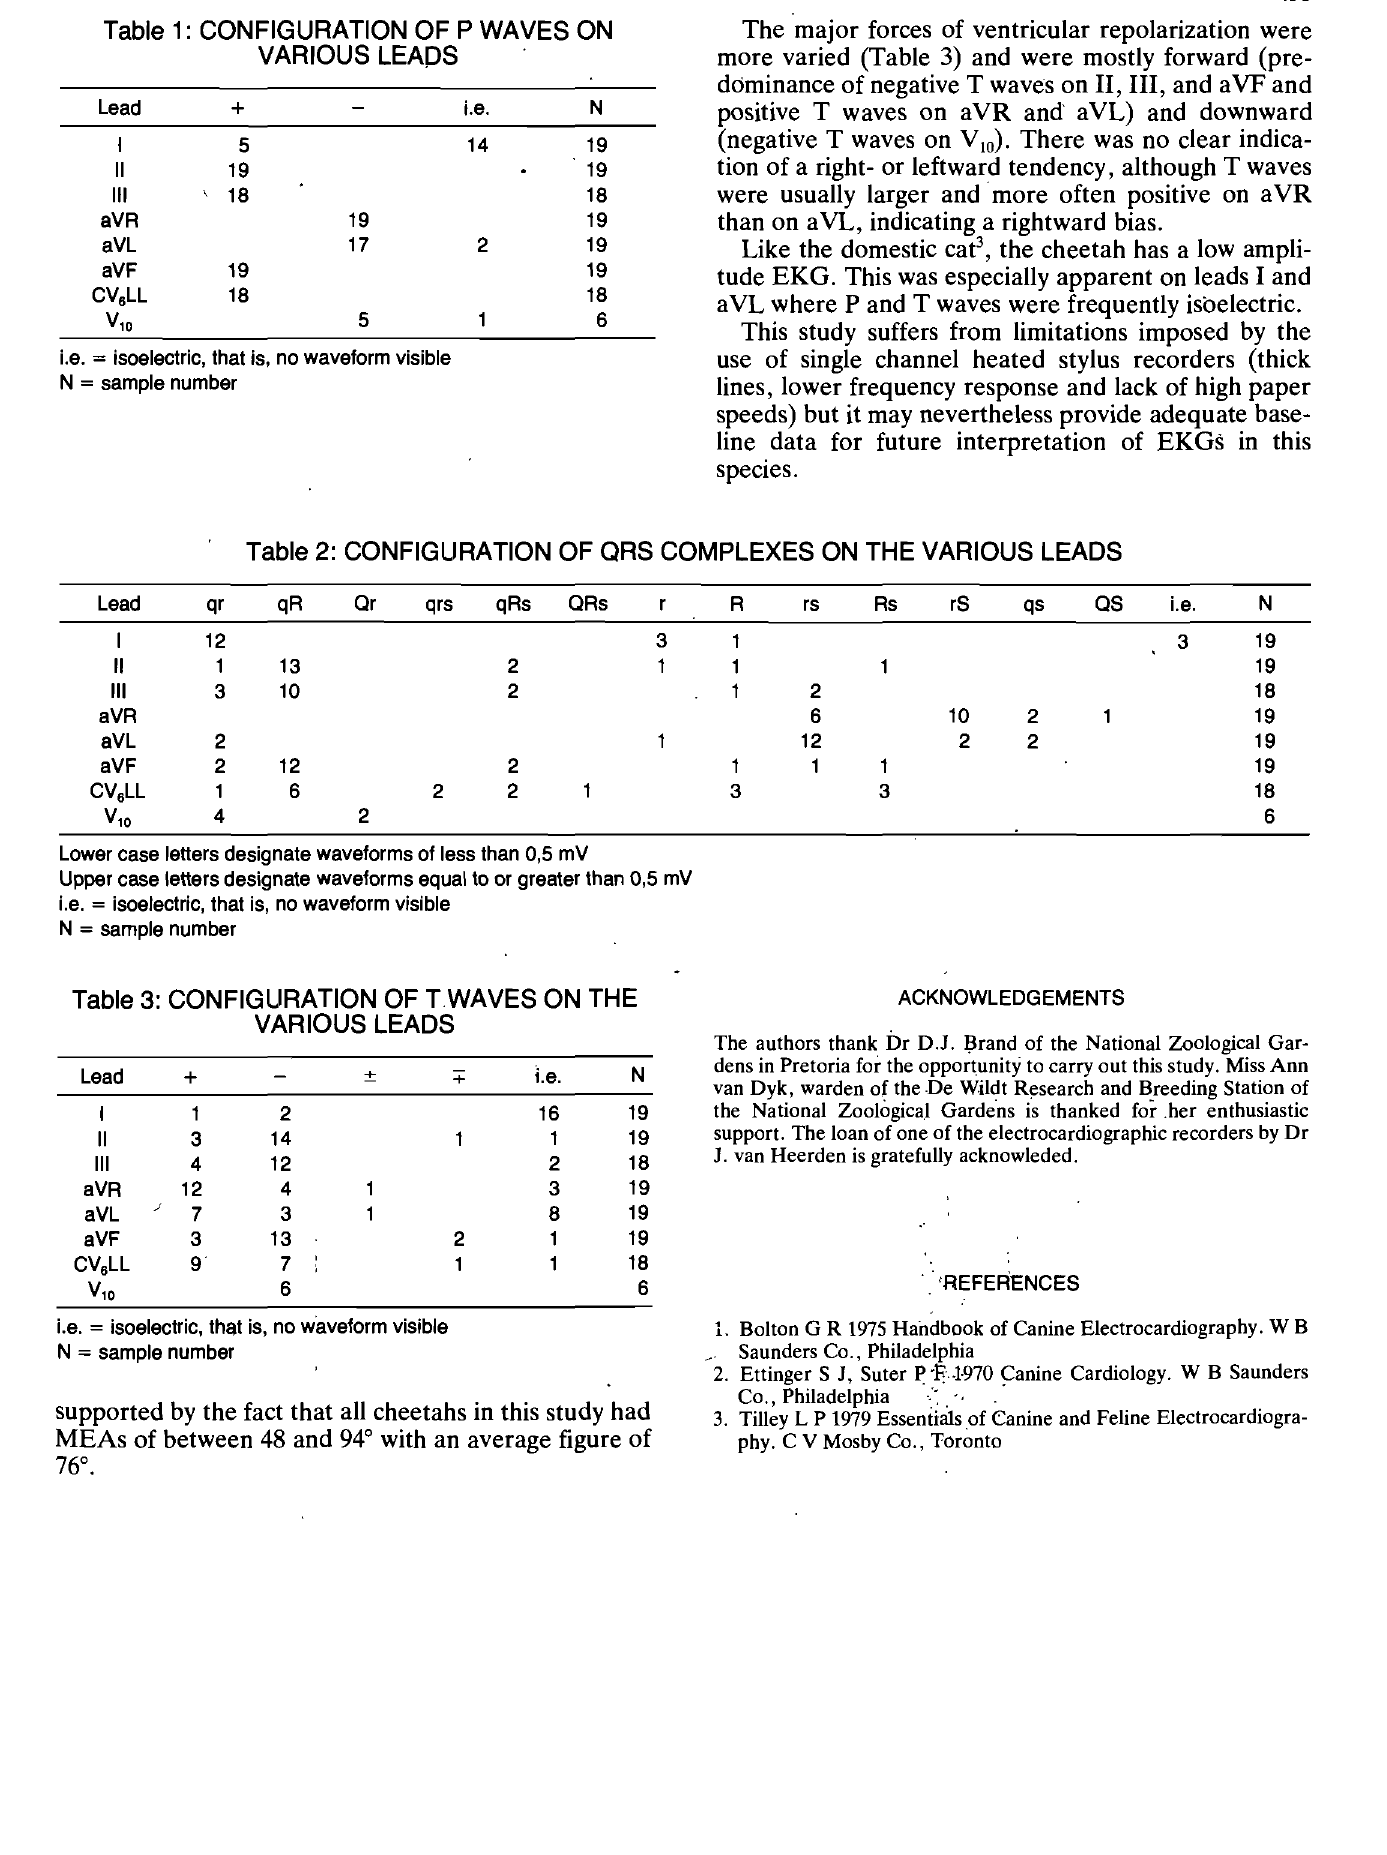
Table 1: CONFIGURATION OF P WAVES ON VARIOUS LEAPS